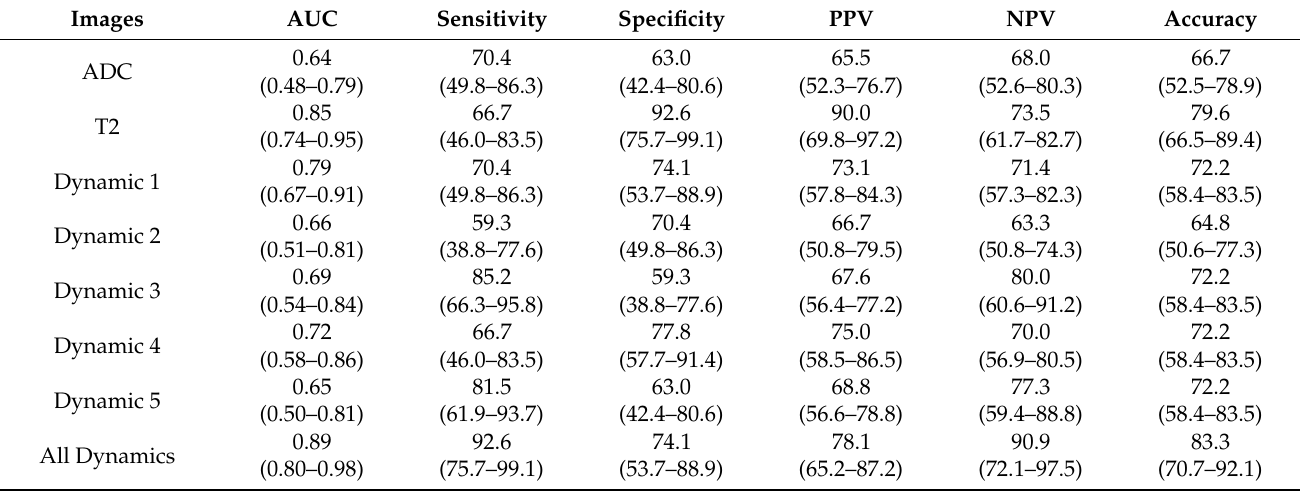
Table 3. Best mean classification accuracies achieved for prediction of pCR based on each